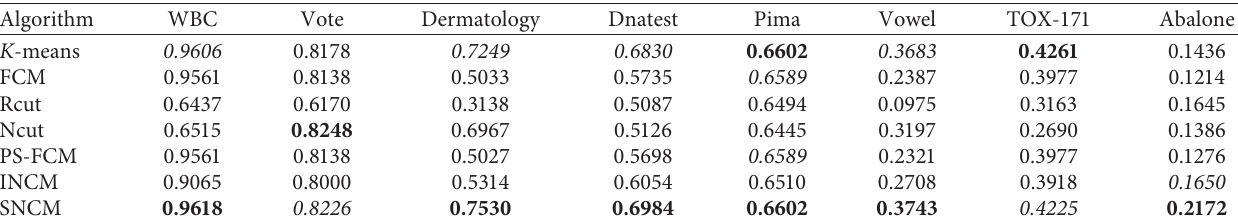
Table 6: ACC comparison of different algorithms under different data